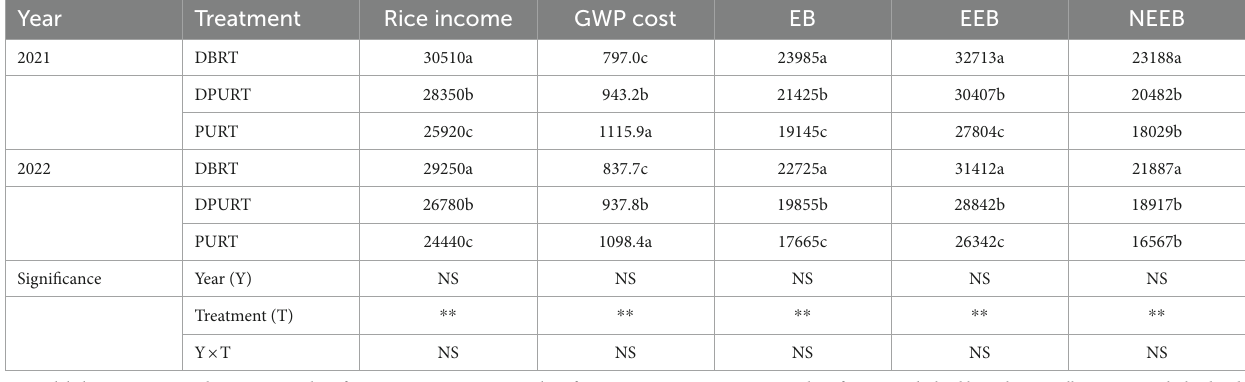
TABLE 10 Rice income, GWP cost, and EB, EEB, and NEEB (CNY ha − 1 ) in three tillage treatments in 2021 and